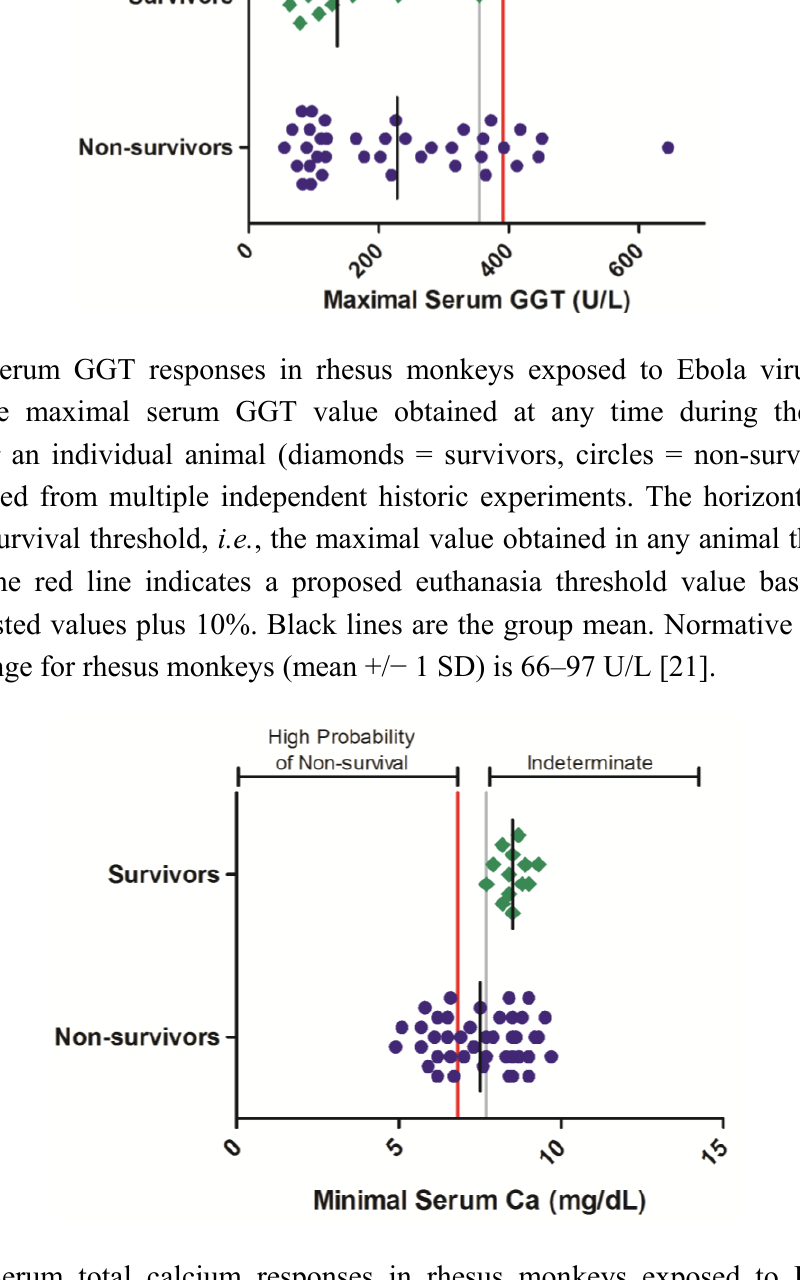
Figure 4. Serum total calcium responses in rhesus monkeys exposed to Ebola virus. Symbols represent the minimal serum total calcium value obtained at any time during the course of infection for an individual animal (diamonds = survivors, circles = non-survivors). Data were compiled from multiple independent historic experiments. The horizontal gray line indicates a survival threshold, i.e. , the maximal value obtained in any animal that survived infection. The red line indicates a proposed euthanasia threshold value based on ROC curve suggested values plus 10%. Black lines are the group mean. Normative serum total calcium reference range for rhesus monkeys (mean +/− 1 SD) is 8.6–9.2 mg/dL